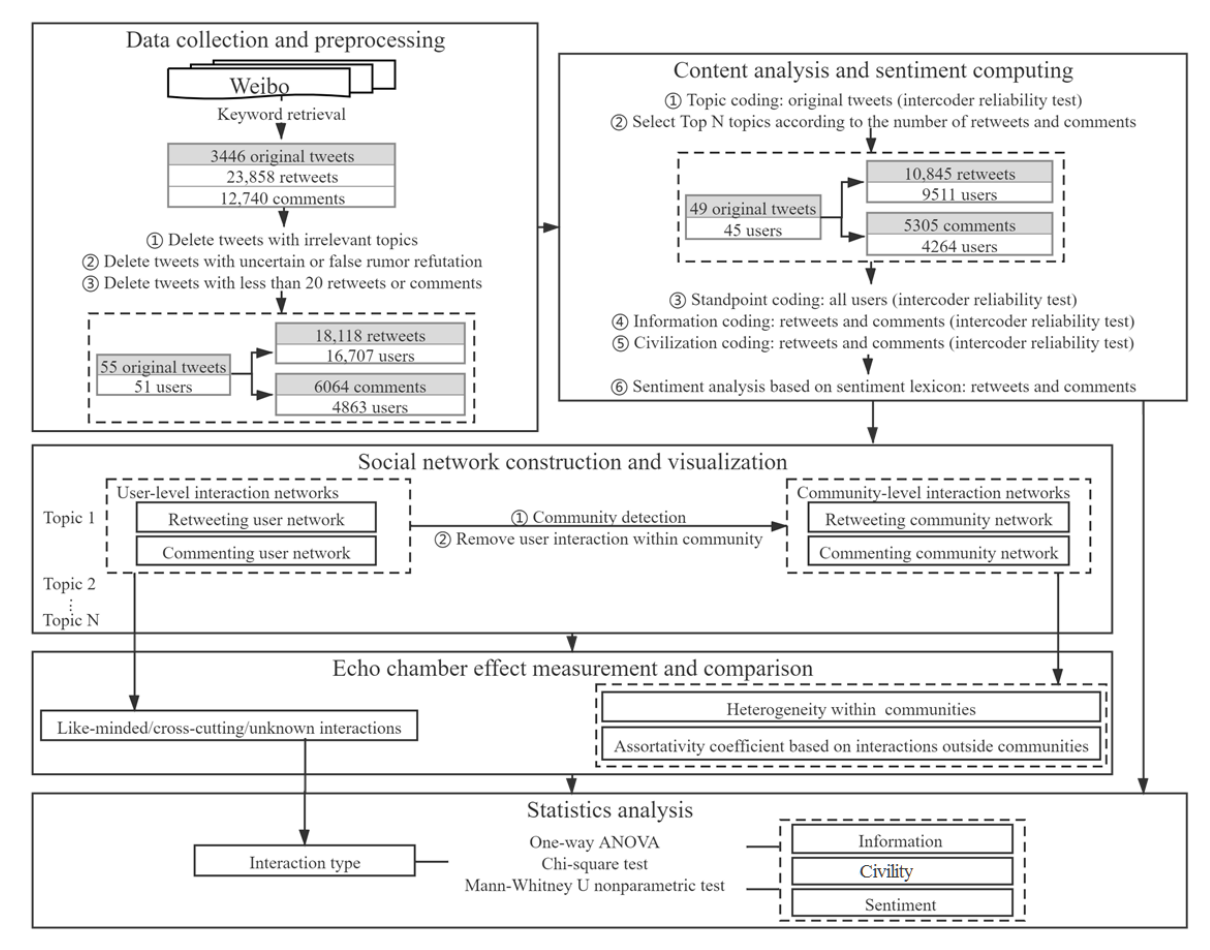
Figure 1. Research design. ANOVA: analysis of